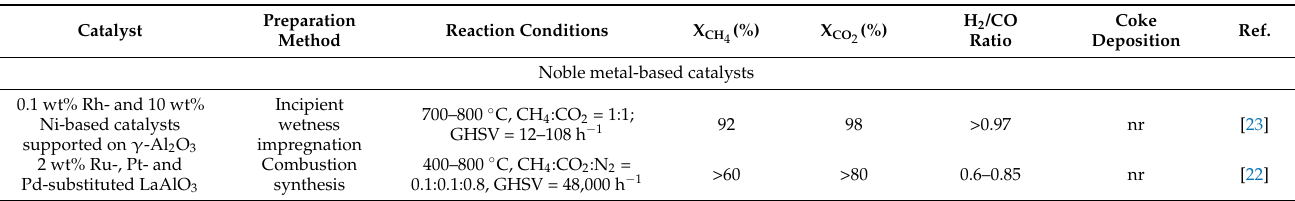
Table 1. Summary of catalytic systems recently reported for H 2 production via